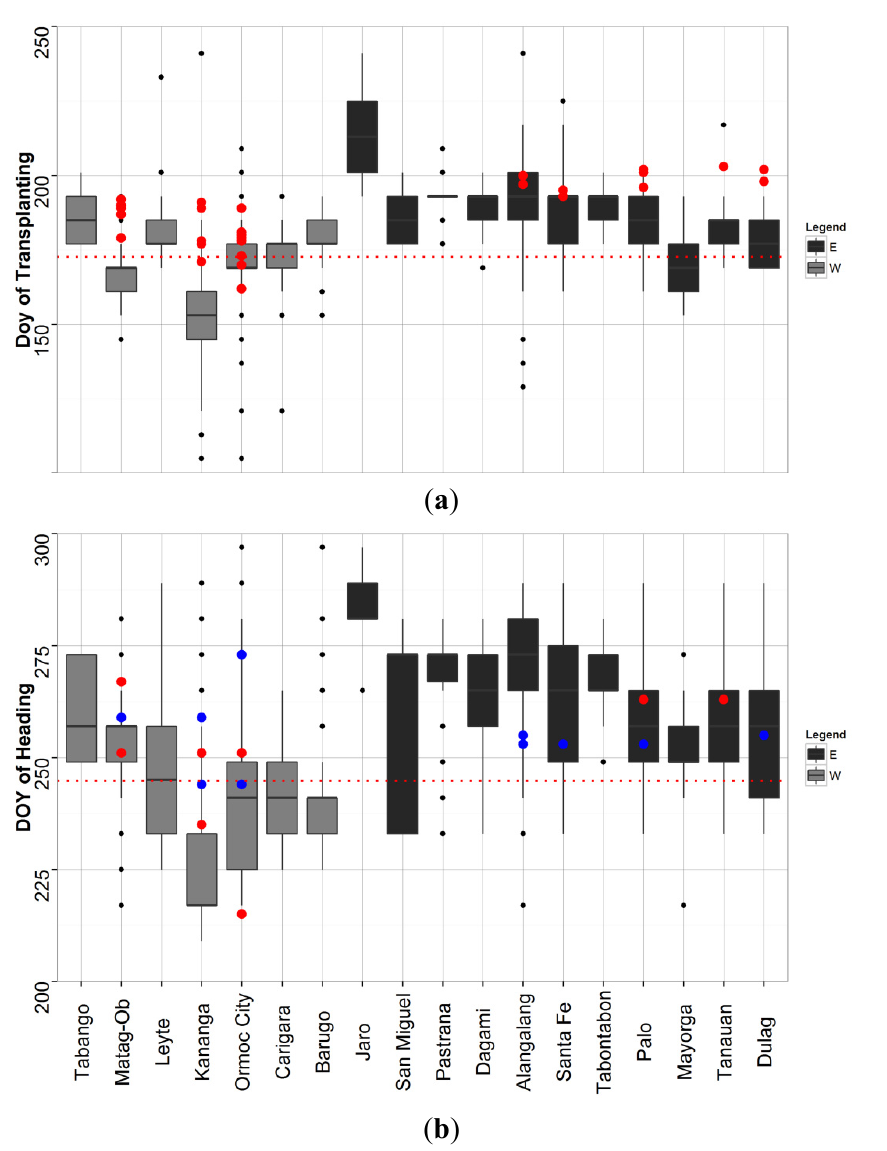
Figure 7. Box plots of the transplanting ( a ) and heading ( b ) dates in 18 municipalities for the 2013 wet season as derived from MODIS data. Red and blue points refer to observed and estimated field dates, respectively. Red dotted line represents the average value for the entire study area. Municipalities are reported from west (Tabango) to east